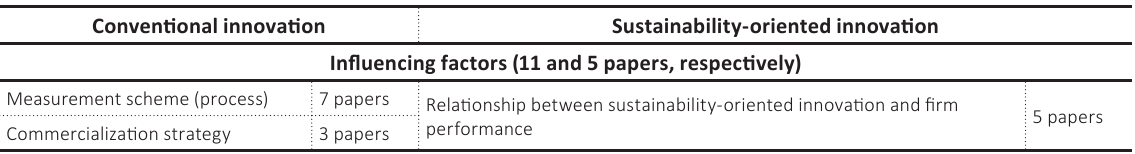
Table 2. Comparative thematic analysis of conventional and sustainable innovation